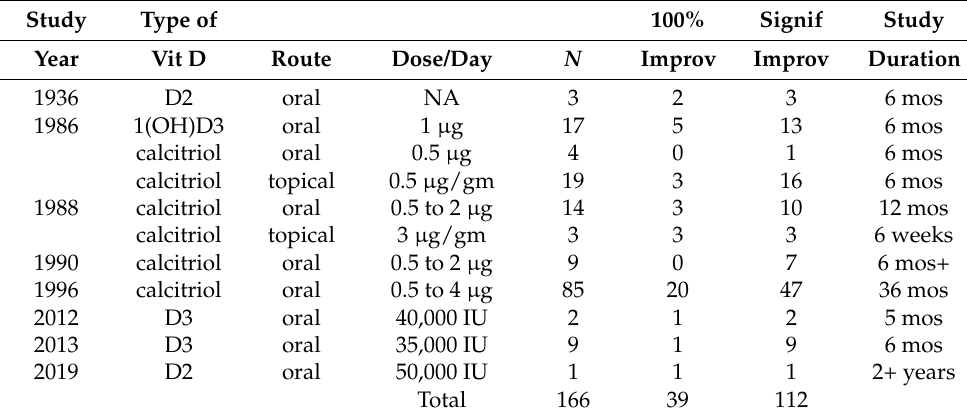
Table 1. Study year, type of vitamin D, route, dose, duration of treatment, number of patients treated, and number showing significant improvement in the oral vitamin D clinical trials and case reports reviewed. Study Type of 100%